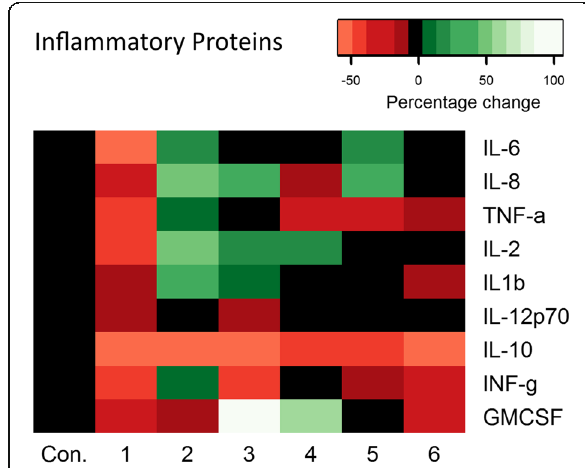
Fig. 2 Differential effects of resveralogues on the senescence- associated secretory phenotype (SASP). Protein levels of various pro-inflammatory SASP factors was determined using Mesoscale ELISA platform in culture medium of senescent HNDF cultures treated with 5 μ M resveralogues 1 – 6. The heat map indicates fold changes. Con = control (vehicle only). Green indicates up-regulation while red denotes down-regulation. The colour scale refers to percentage change in expression. Experiments were carried out in duplicate a total of 10